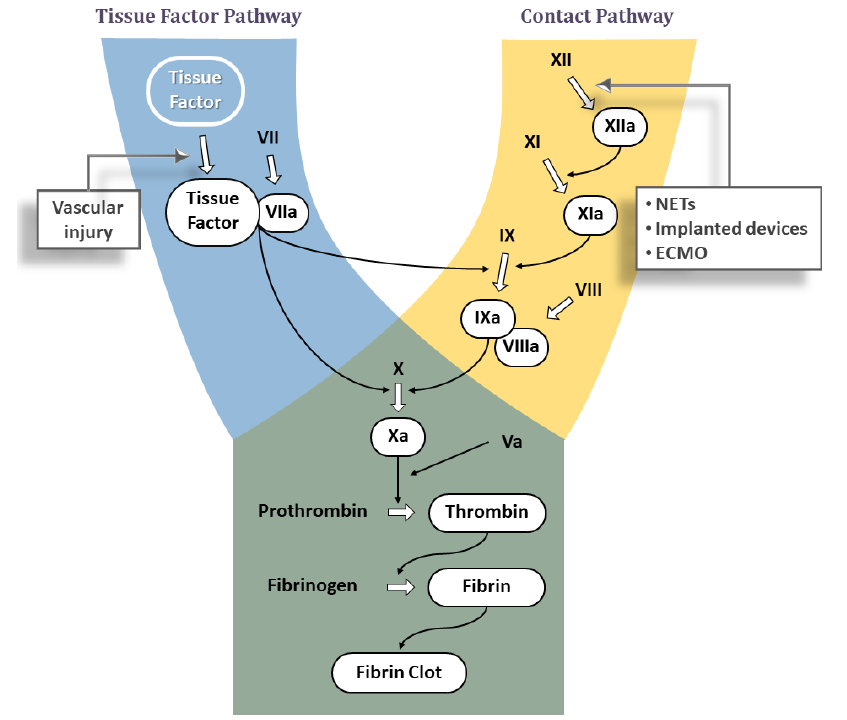
Figure 1. The classic model of the coagulation cascade with the Tissue Factor/extrinsic, the Con- tact/intrinsic and the common pathways. Triggering factors for both pathways are shown in square boxes. NETs: neutrophil extracellular traps, ECMO: extracorporeal membrane oxygenation.